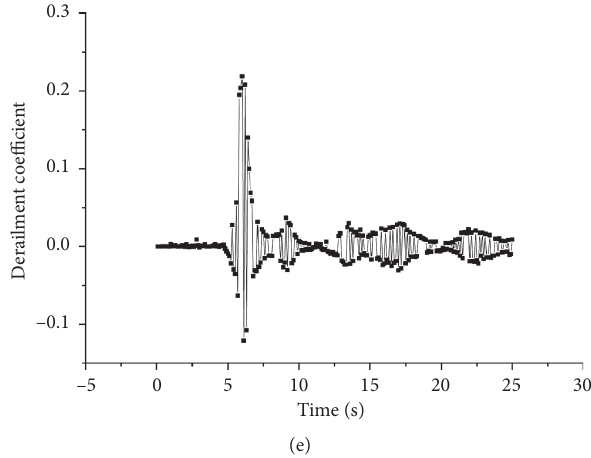
Figure 19: Wheel-track-subgrade time history under the Taft wave. (a) Lateral acceleration-time curve of the wheel. (b) Lateral force-time curve between the wheel and rail. (c) Vertical force-time curve between the wheel and rail. (d) Wheel load reduction rate-time curve. (e) Derailment coefficient-time